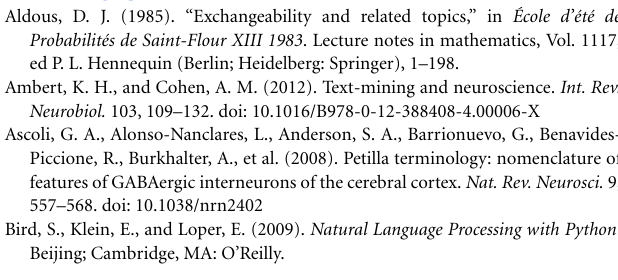
Figure S1 | Illustration of NeuroElectro relational database